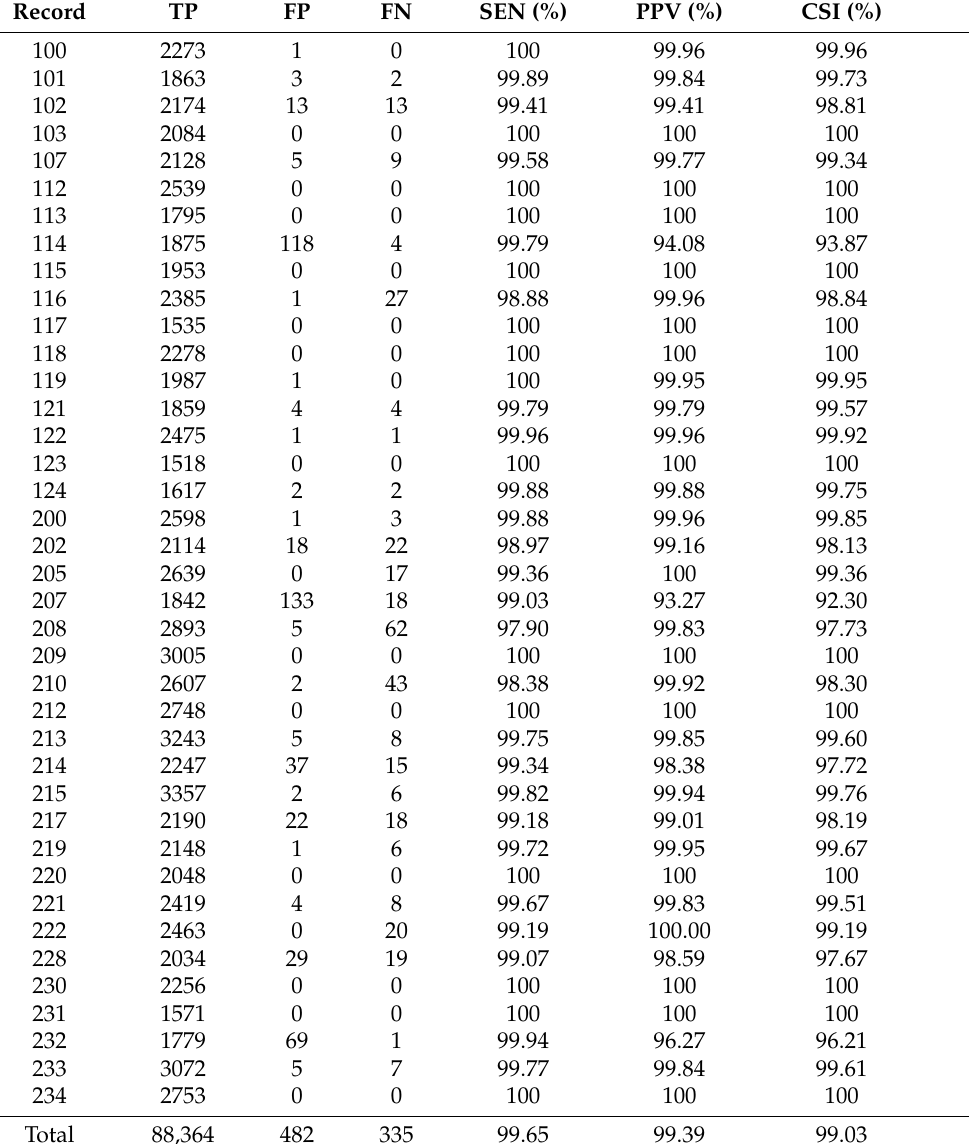
Table 1. Results of evaluation of proposed method on MIT-BIH